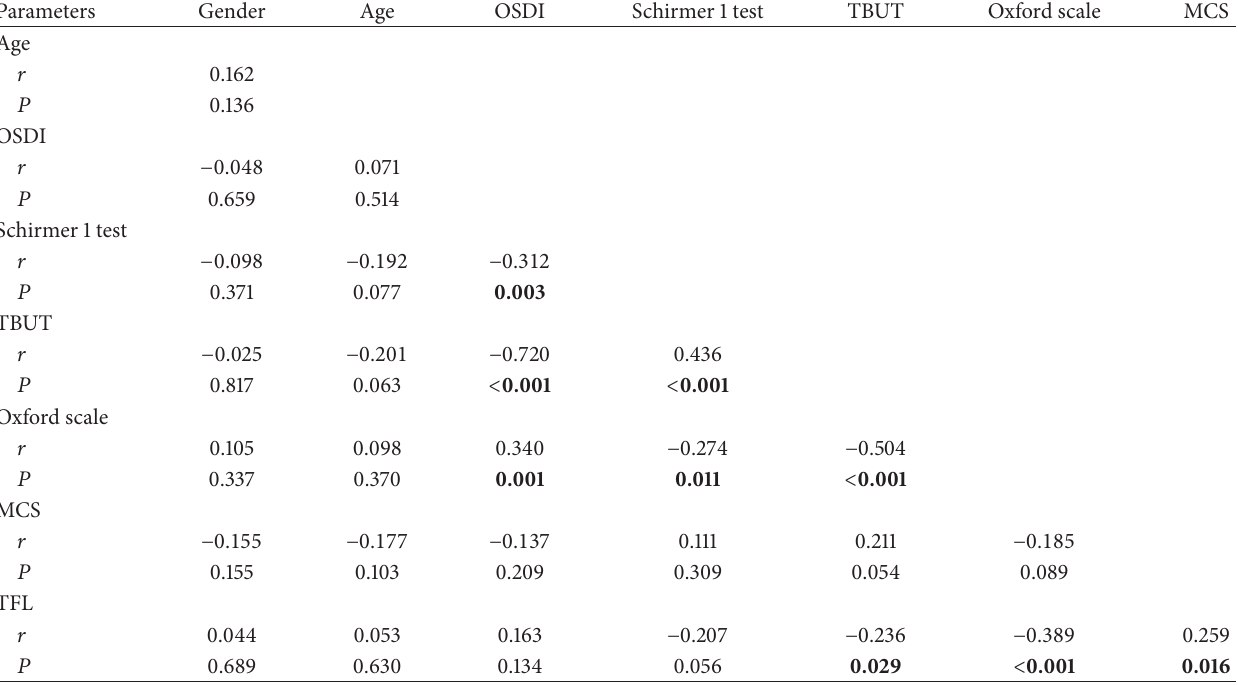
Table 3: Statistical results of correlations between dry eye clinical